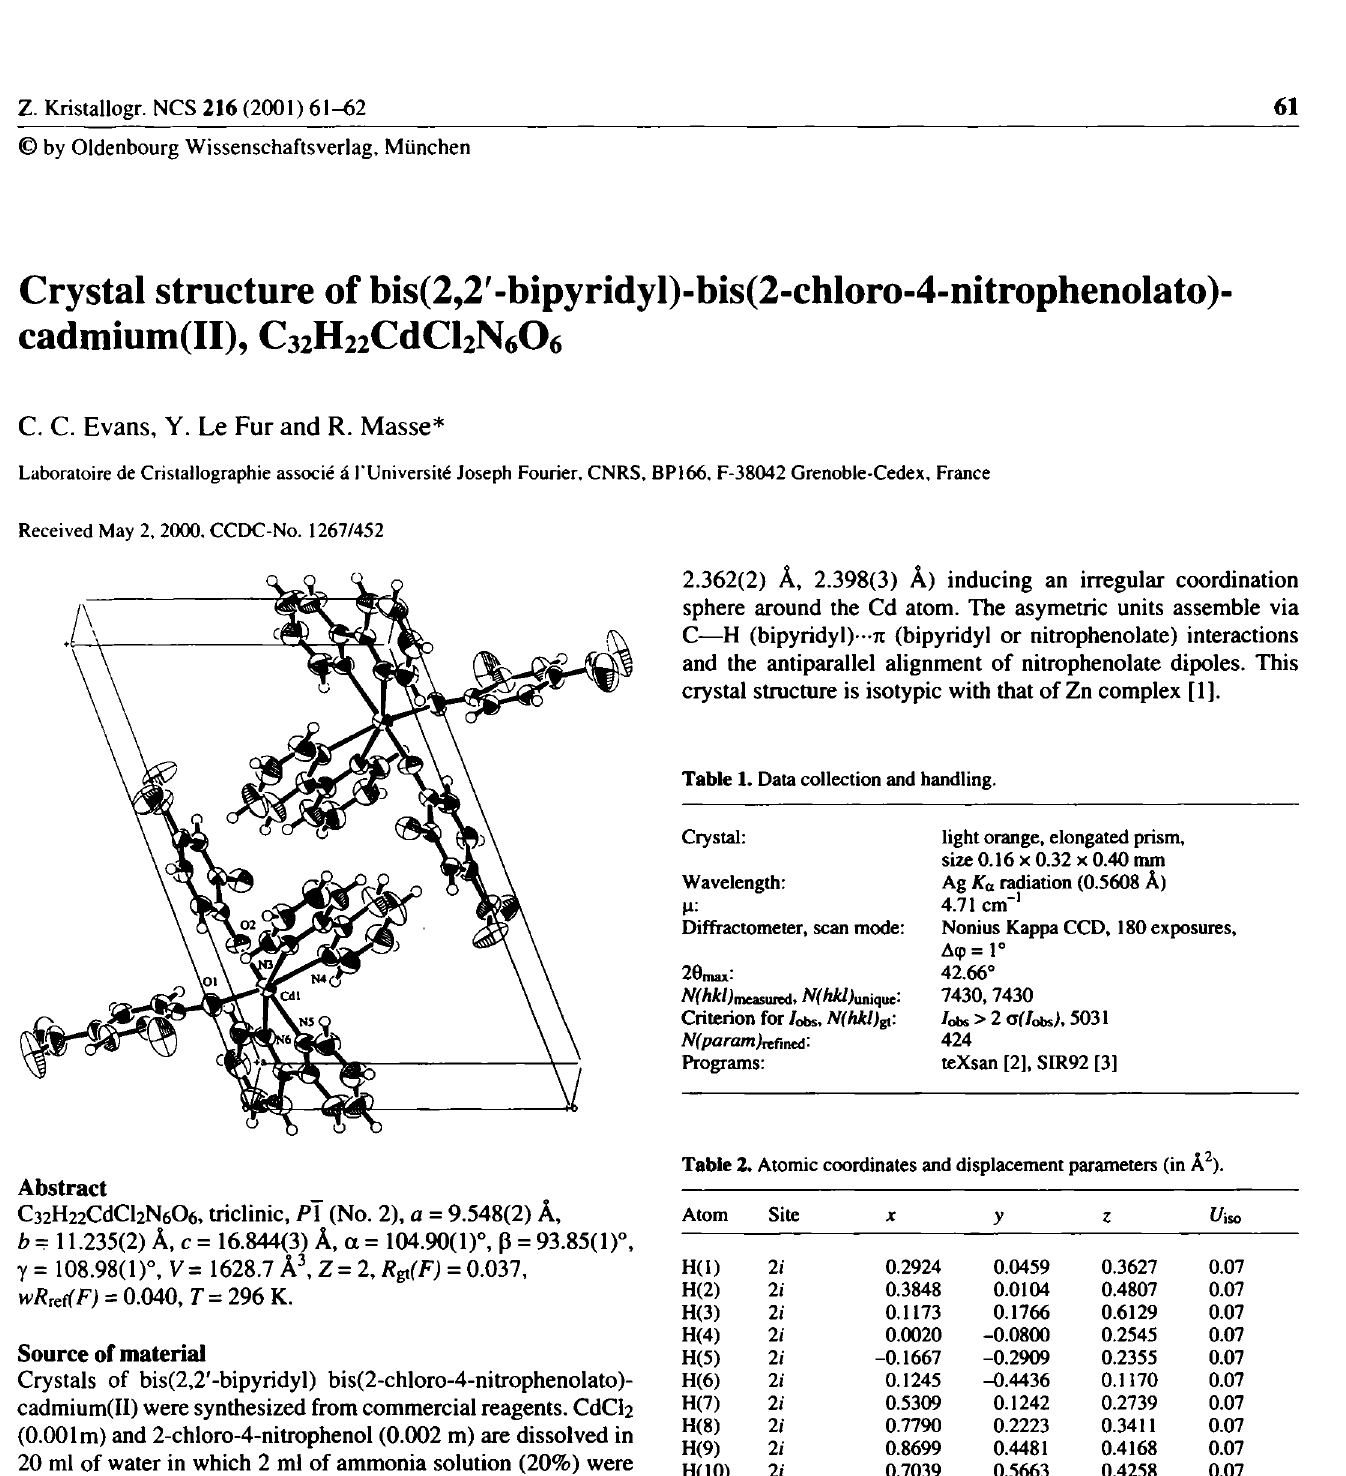
Table 2. Atomic coordinates and displacement parameters (in A 2